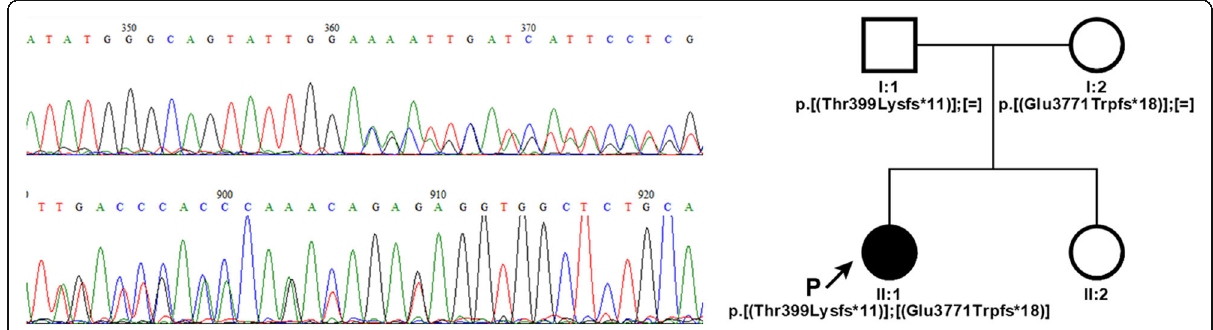
Fig. 1 Sequence chromatograms of the variants identified in the proband. The chromatograms show the c.1196_1202del: p.(Thr399Lysfs*11) (upper panel) and the c.11310_11313del: p.(Glu3771Trpfs*18) (lower panel) heterozygous deletions. The family pedigree shows the compound heterozygous state of these two variants in the